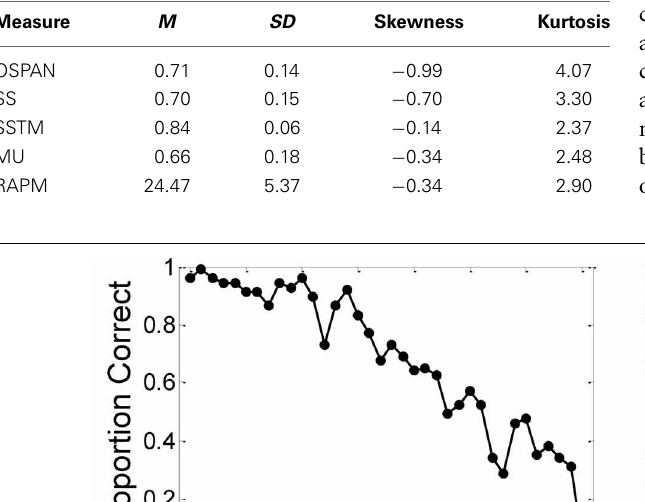
in correlations of 0.52, 0.23, and 0.09, respectively, between WMC and overall Raven’s performance. All bootstrap results are based on 10,000 replications and the shaded areas represent the 95% confidence regions for the bootstrapped means. The framed bottom-left panel matches the overall correlation and item-wise results in the top right